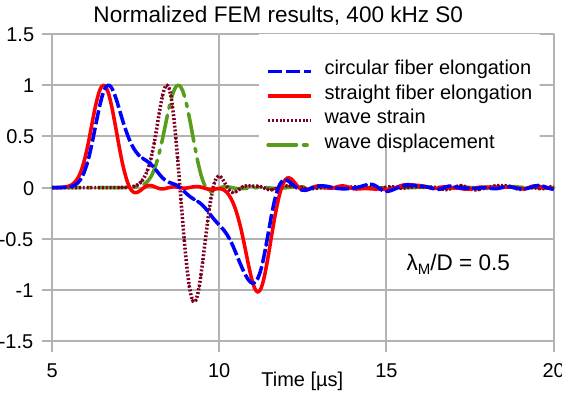
Figure 10. Extremely distorted outputs of straight and circular fiber transducers in response to the indicated plane wave strain and displacement result for short mechanical wavelengths 2 λ M = D